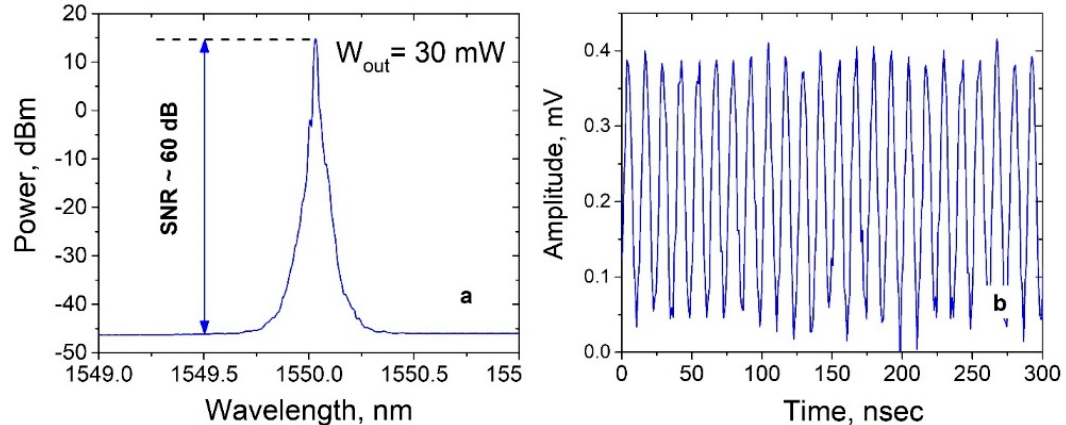
Figure 2. Scheme of the DFB and hybrid laser configurations and related measuring equipment.